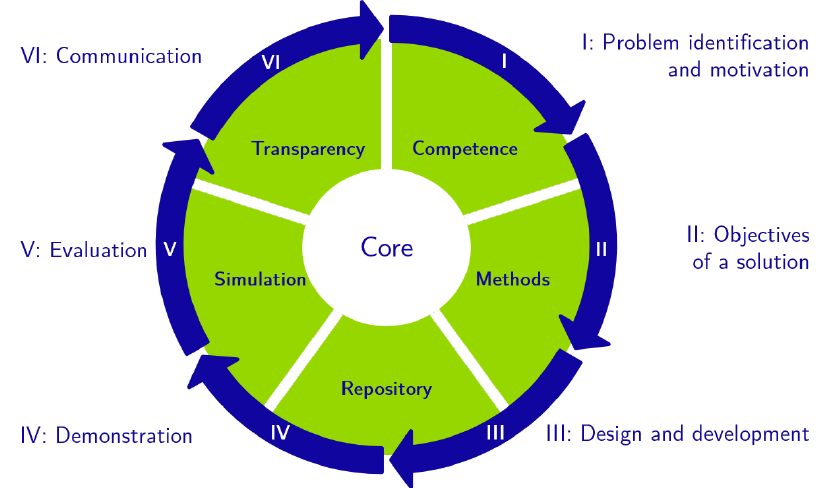
Figure 1. New key services of the open energy R&D platform extending the work of